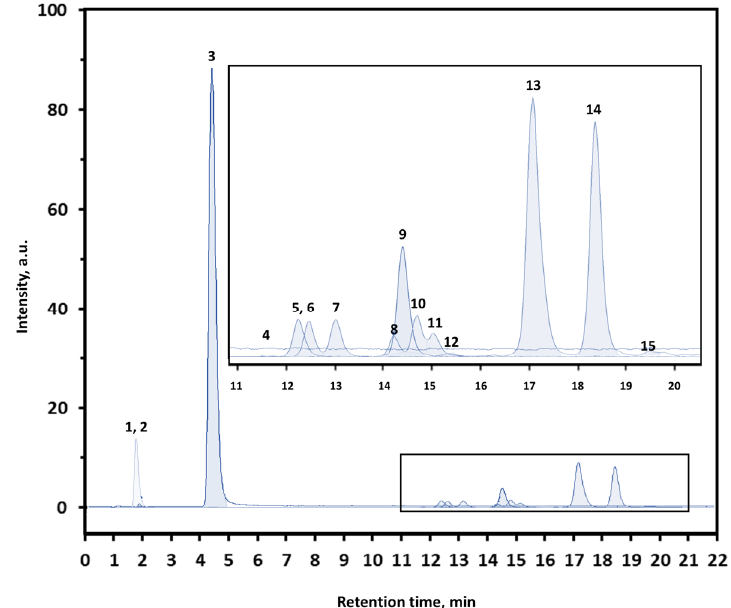
Figure 4. HPLC run of the crude reaction mixture of γ -irradiated N 2 O-saturated aqueous solutions containing 1.0 mM of S-methyl-cysteine residue derivative 2 (peak 3) at natural pH at a dose of 800 Gy (dose rate of 46.7 Gy min − 1 ); the consumption of 2 lead to the formation of 14 products; peaks 1 and 2 assigned to compounds 5 and 6 , respectively (cf. Scheme 6). Inset: expansion of the chromatogram between 11 and 21 min.